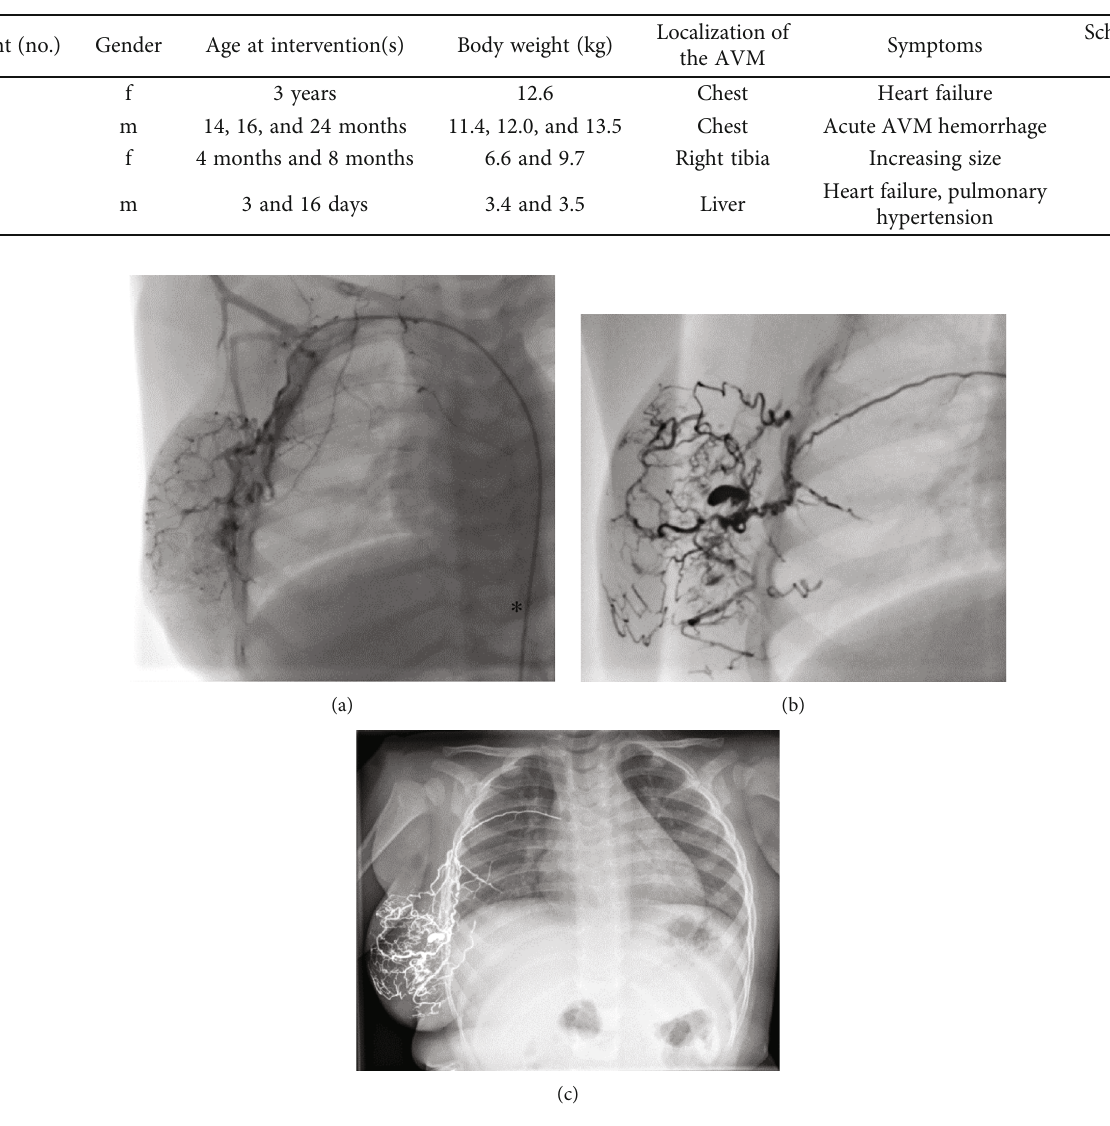
Table 1: Patients ’ characteristics.